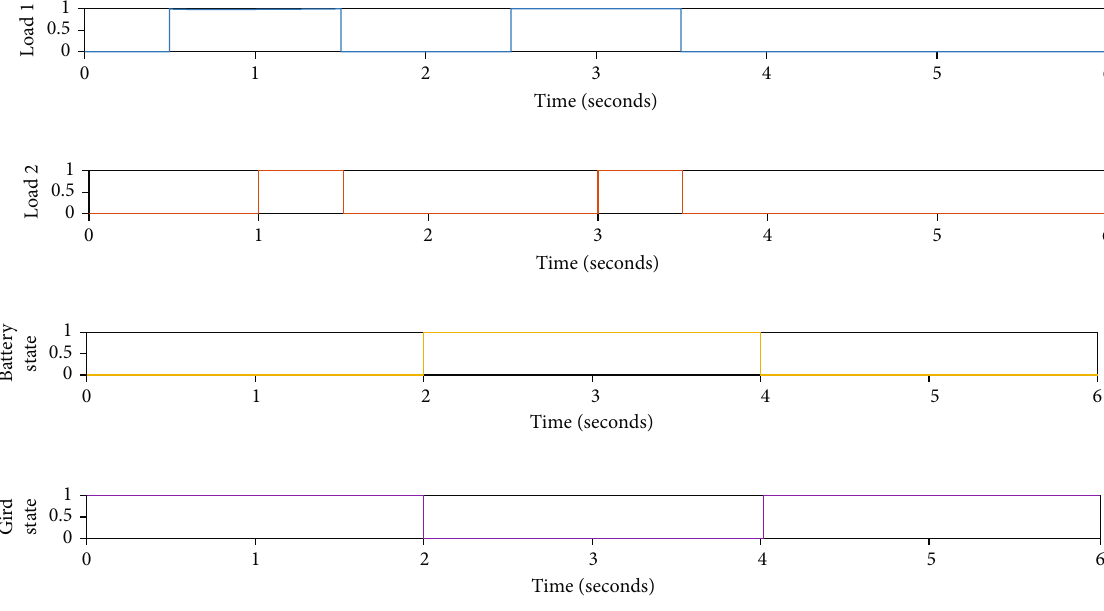
Figure 5: Switching characteristics of loads, battery, and power